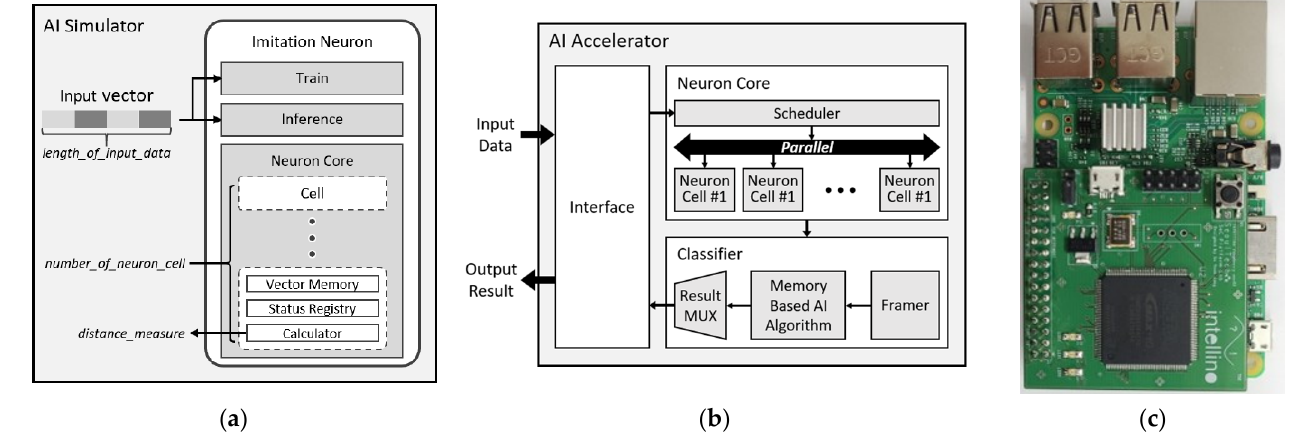
Figure 2. ( a ) Construct of the proposed simulator; ( b ) Architecture of the AI accelerator; ( c ) Prototype board of AI accelerator with embedded processor